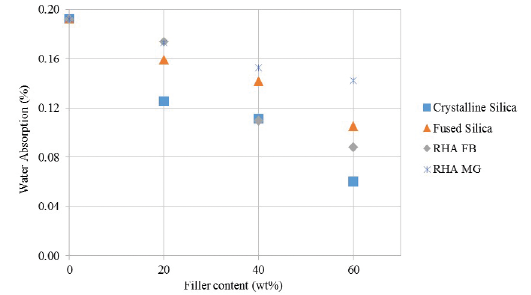
Figure 16. Effect of increasing proportions of filler on water absorption of composites